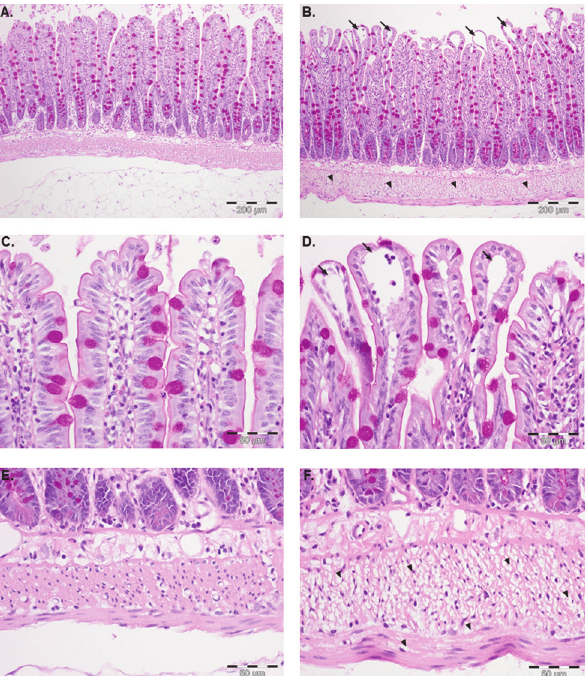
Fig 3. Histomorphology of normal intestines and of PAF-induced intestinal edema. Periodic acid-Schiff (PAS)-stained sections of longitudinal intestinal slices. A., C. and E. Normal morphology in control specimens at 63 minutes (n = 4). B., D. and F. The slide shows the acute morphologic changes in the intestinal mucosa and the gut wall three minutes after stimulation with PAF (n = 4). Fluid accumulations at the villi tips (arrows) and in the muscular layers (arrowheads) can be